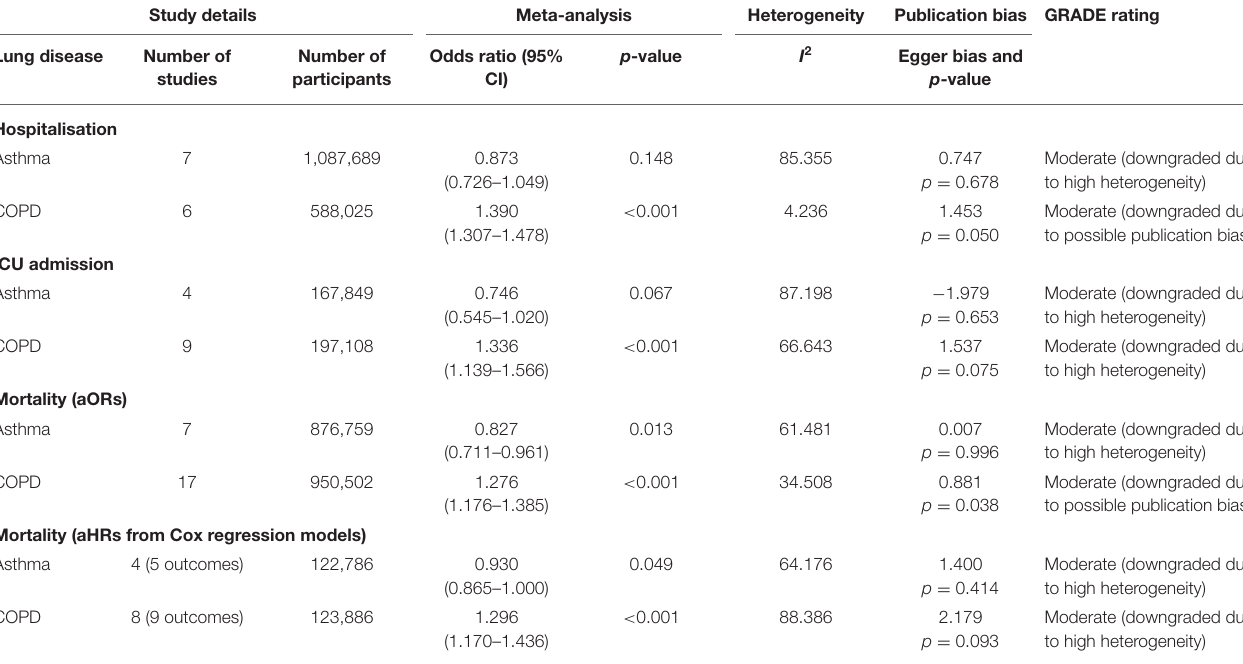
TABLE 2 | Meta-analysis showing the pooled adjusted risk of unfavorable COVID-19 outcomes in subjects with asthma or COPD.